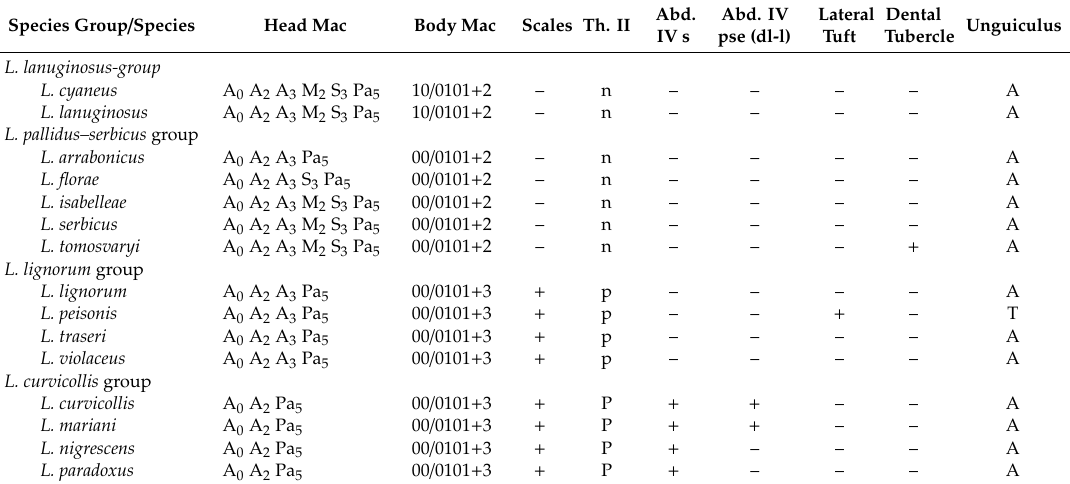
Table 2. Lepidocyrtus species groups and related species